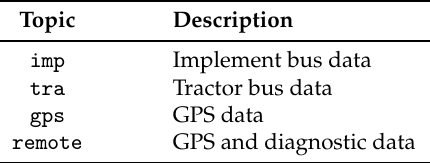
Table 5. Data stored in different Kafka topics.